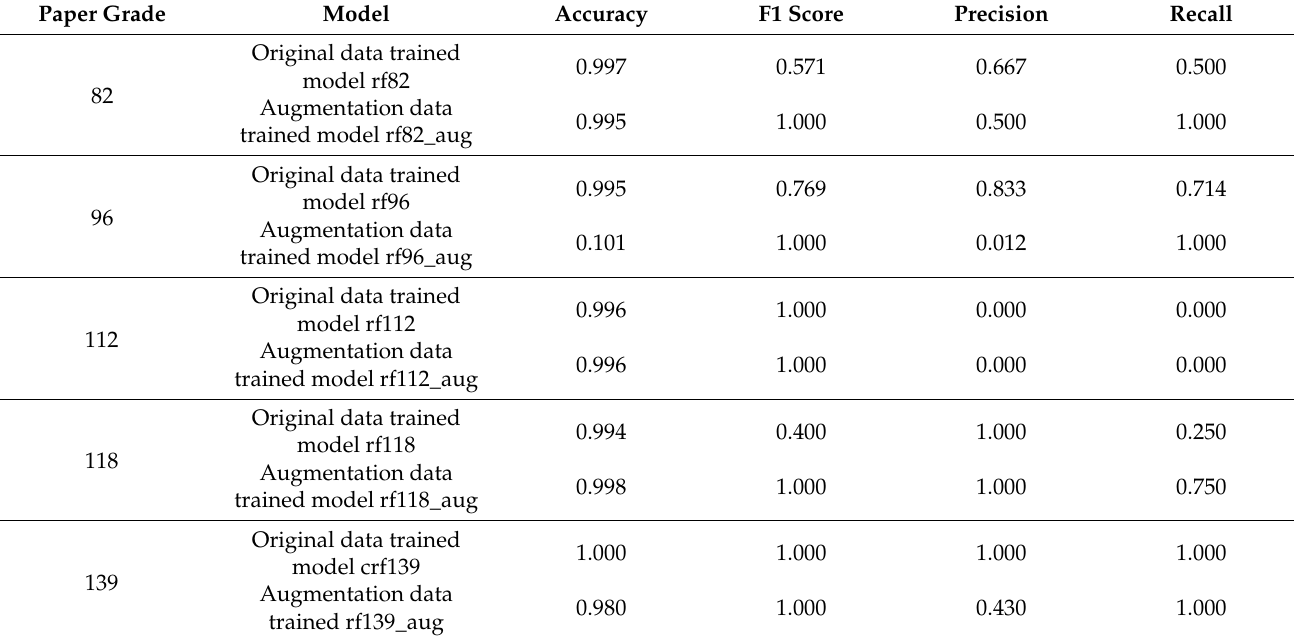
Table 9. The performance of random